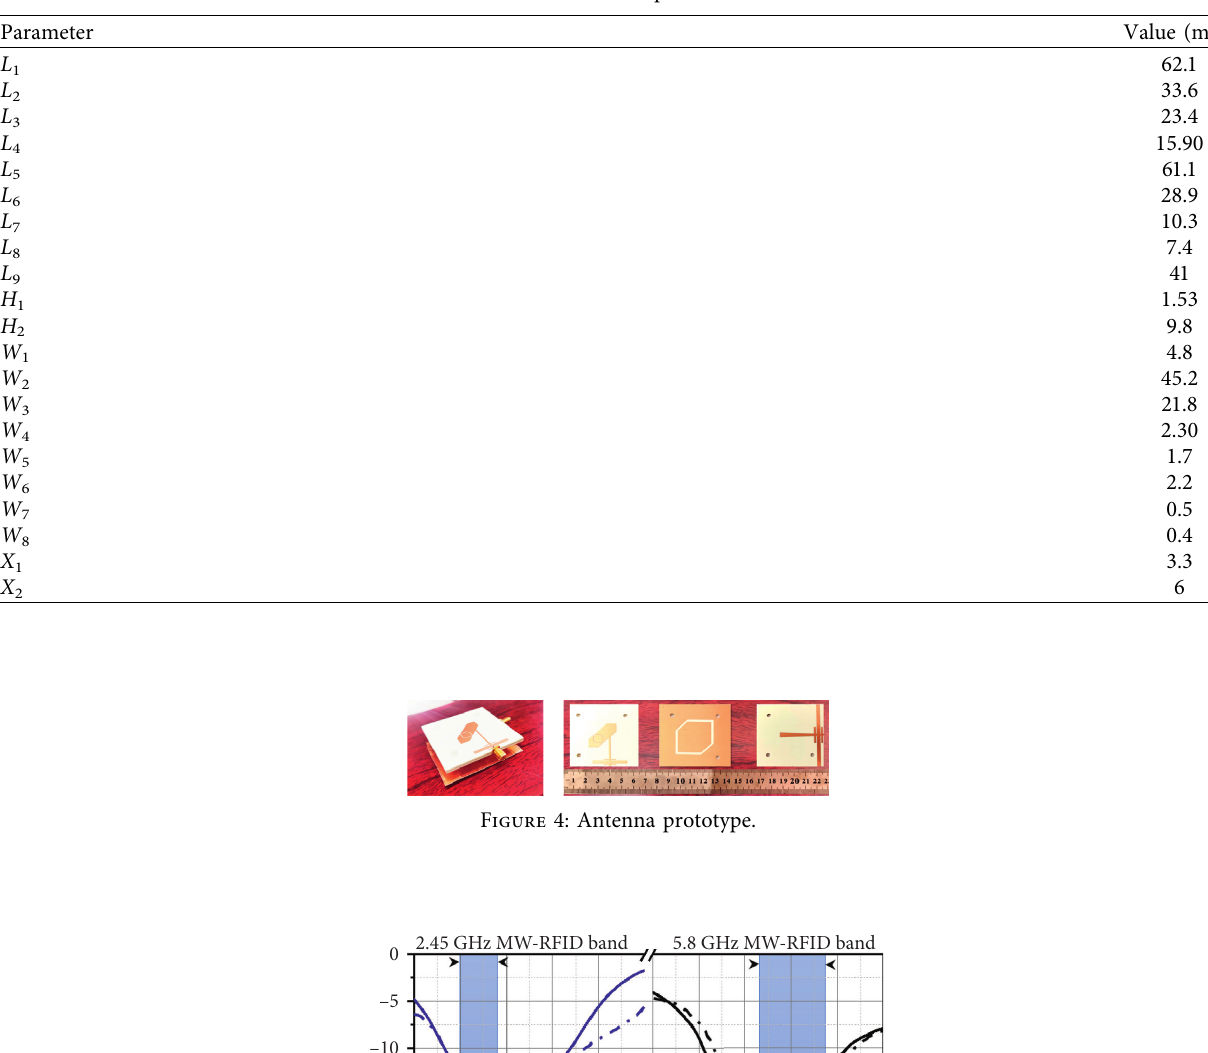
Table 1: Structure parameters.